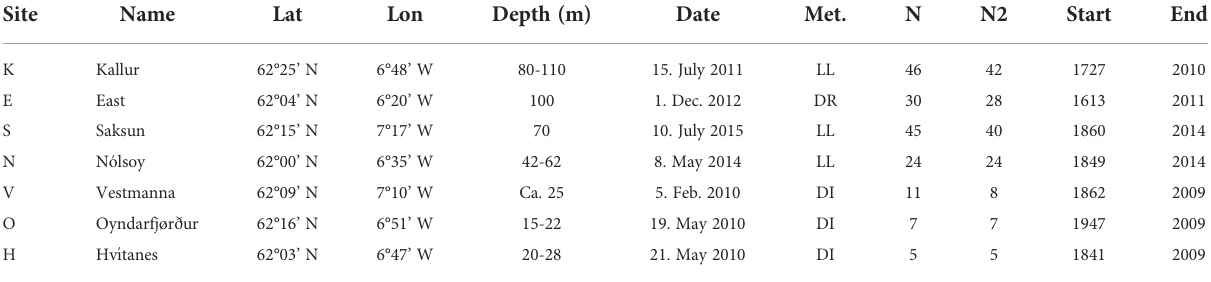
TABLE 1 Description of the Arctica islandica sample locations (sites) as well as number of shells sampled (N) and used in the study (N2) and time span in years of the oldest individual for each site. The true age is 15 years older than the depicted age. Site